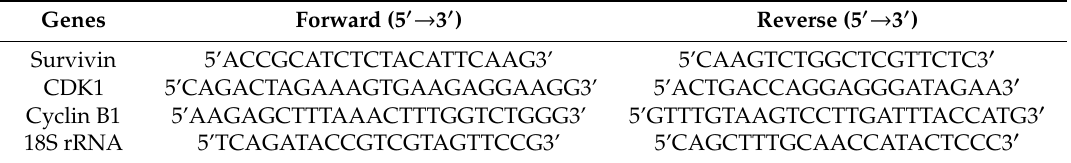
Table 1. List of primers used for the quantitative real-time